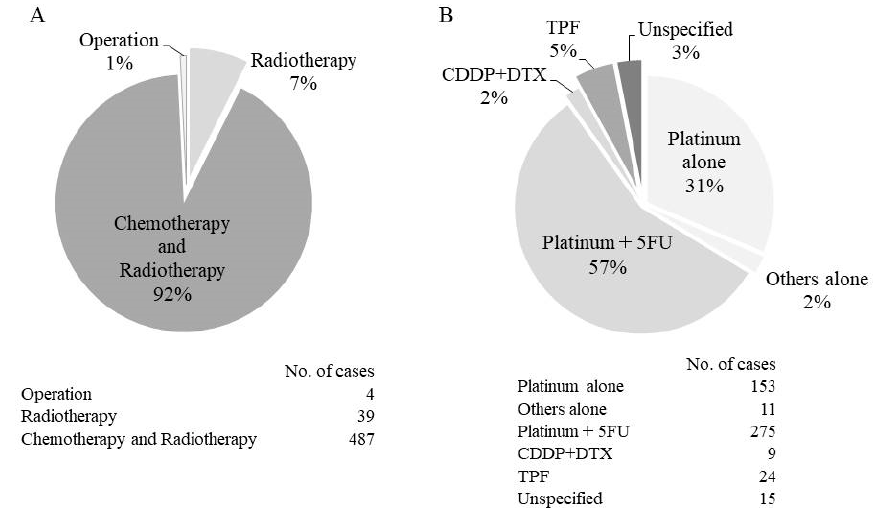
Figure 5. Details of curative treatments: ( A ) The details of curative therapy; ( B ) the breakdown of the chemotherapy used in 487 cases in which curative chemotherapy and radiotherapy were performed. Platinum includes cisplatin, carboplatin, and nedaplatin. Others alone includes eight cases of S-1 and three cases of DTX. CDDP, cisplatin; DTX, docetaxel; 5FU, 5-fluorouracil; S-1, tegafur / gimeracil / oteracil; TPF, docetaxel / cisplatin / fluorouracil.